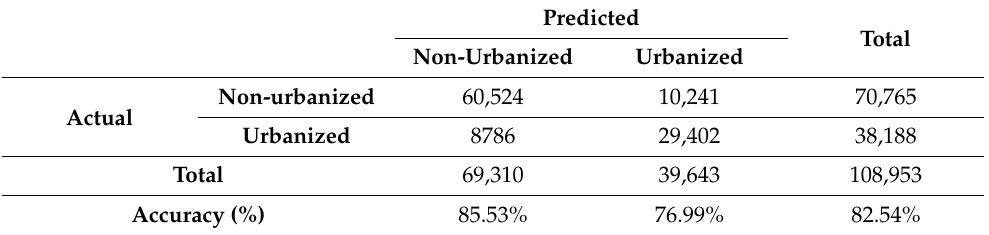
Table 5. Accuracy of XGBoost model.